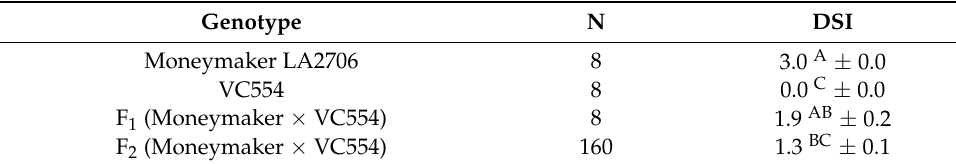
Table 3. Average ToBRFV disease severity index (DSI) of the resistant genotype (VC554), the suscep- tible genotype (Moneymaker), their F 1 hybrid and F 2